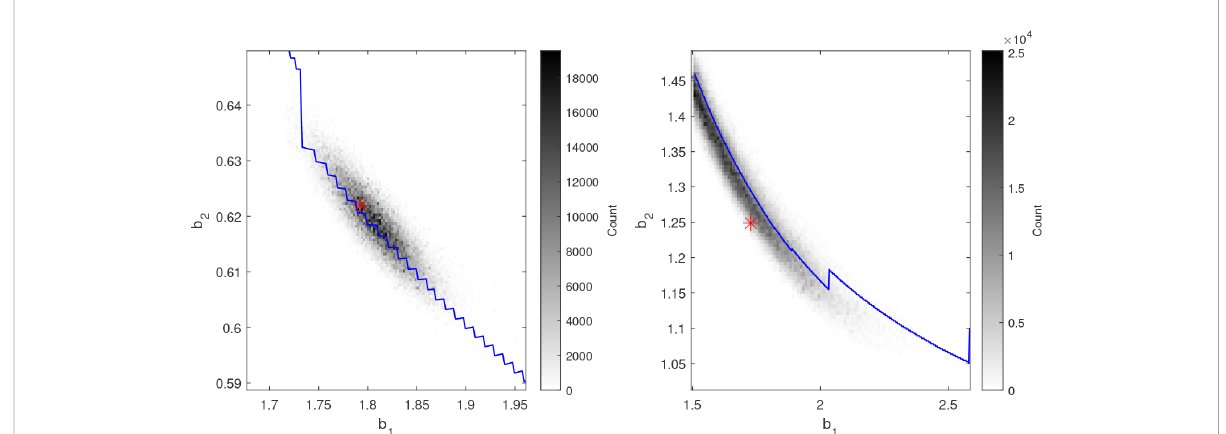
FIGURE 3 Histograms of the posterior distribution of b 1 and b 2 from the AM algorithm (gray-scale) together with the estimated ^ g P (blue curves) and the generating parameter values (red asterisks) for two synthetic data sets. The ^ g P -curves coincide with ridges in the posterior distributions and the minimal distances between the curves and the generating parameters are short.